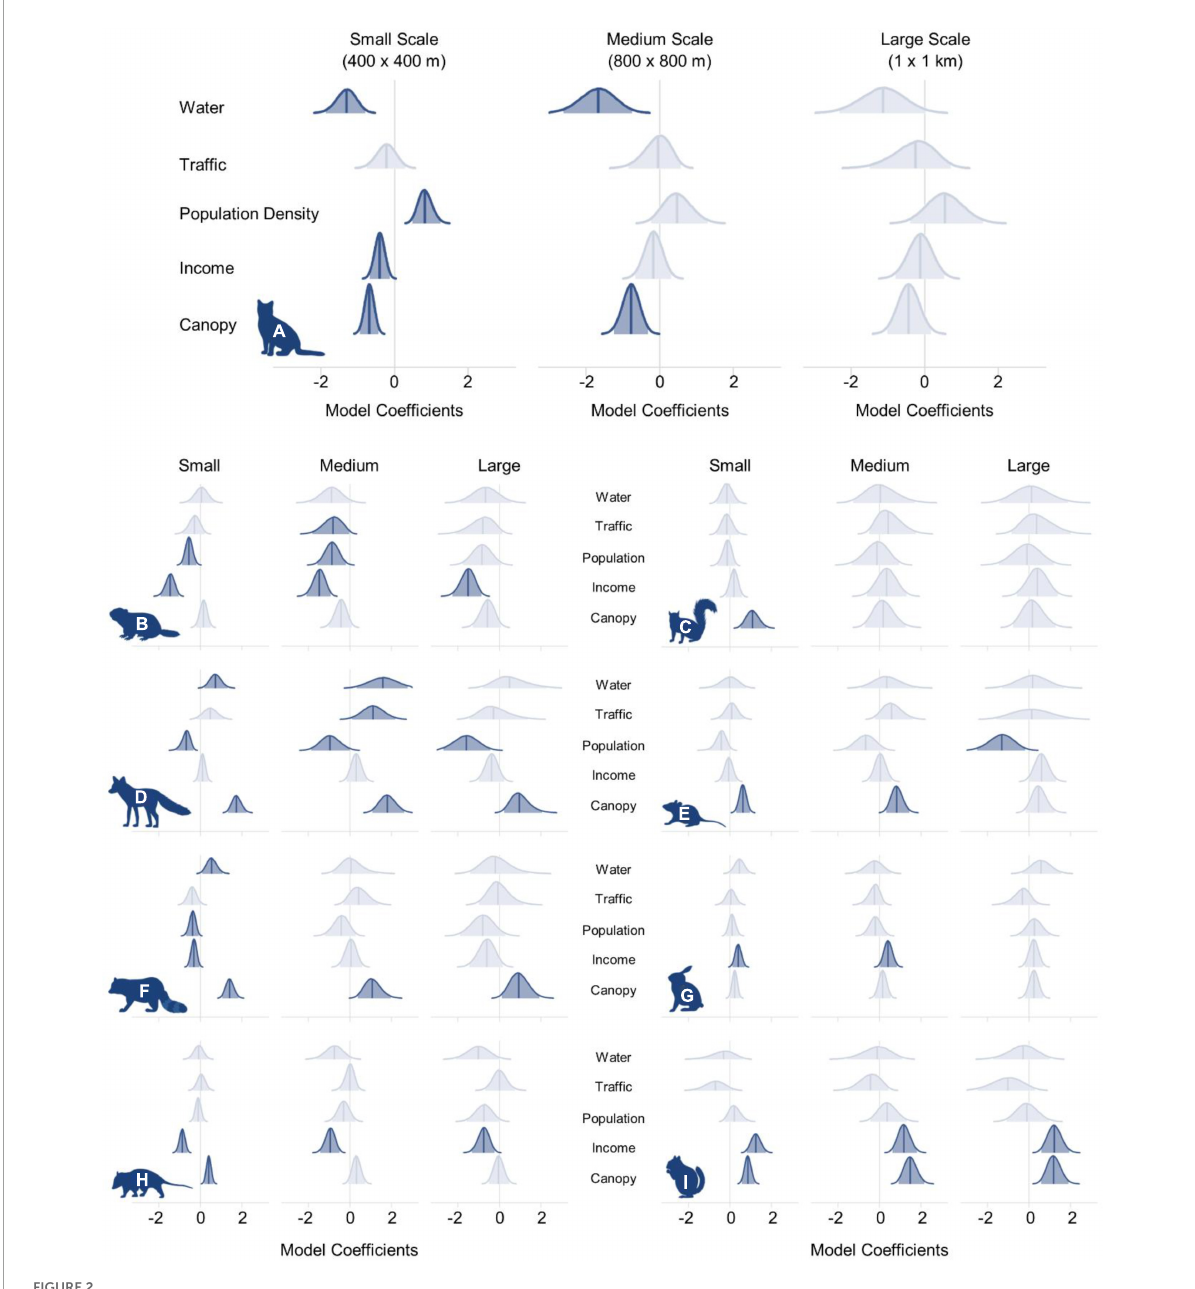
FIGURE2 Posterior distributions of model coefficients for (A) domestic cat, (B) groundhog, (C) eastern gray squirrel, (D) red fox, (E) white-footed mouse, (F) raccoon, (G) eastern cottontail, (H) , Virginia opossum, and (I) eastern chipmunk. Solid blue lines indicate the full posterior distribution and shaded regions represent the 95% Bayesian credible interval. Vertical blue lines denote the median posterior value. Distributions colored in light blue indicate that the 95% credible interval overlapped